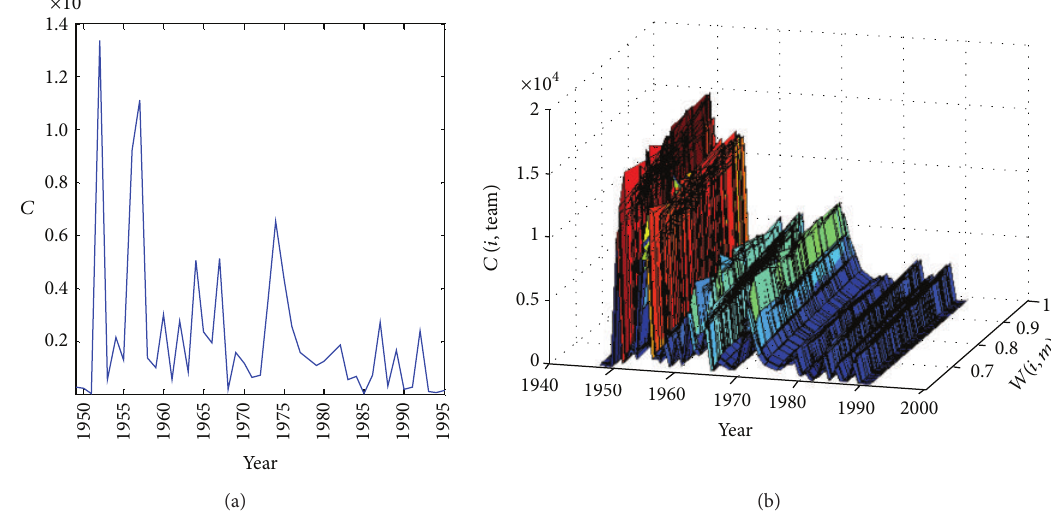
Figure 6: Innovation ability 𝐶 for TD Lee cooperation team. (a) 𝐶 versus year; (b) ( 𝐶(𝑖, team ),𝑊(𝑖, 𝑚) ) versus year.